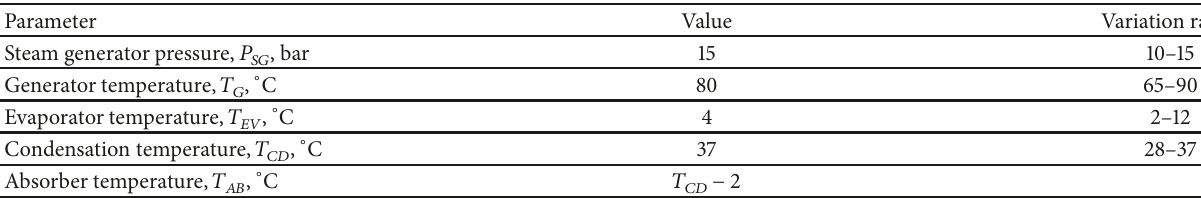
Table 1: Simulation input data.